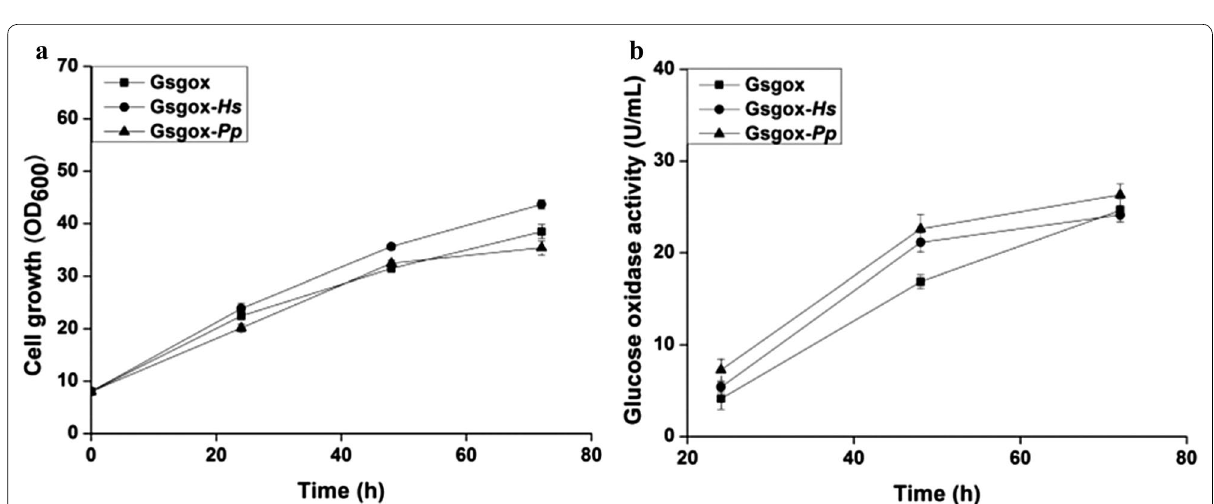
Fig. 3 Effects of Hac1p homologue co-expression on Gox expression. a Cell growth profile. b Gox activity profile. GSgox (square), GSgox- Hs , (GSgox with overexpressed Hs Xbp1, circle), GSgox- Pp (GSgox with overexpressed pp Hac1p, triangle). Three parallel flasks are tested for each strain at 30 °C. Error bars represent deviations ( n =